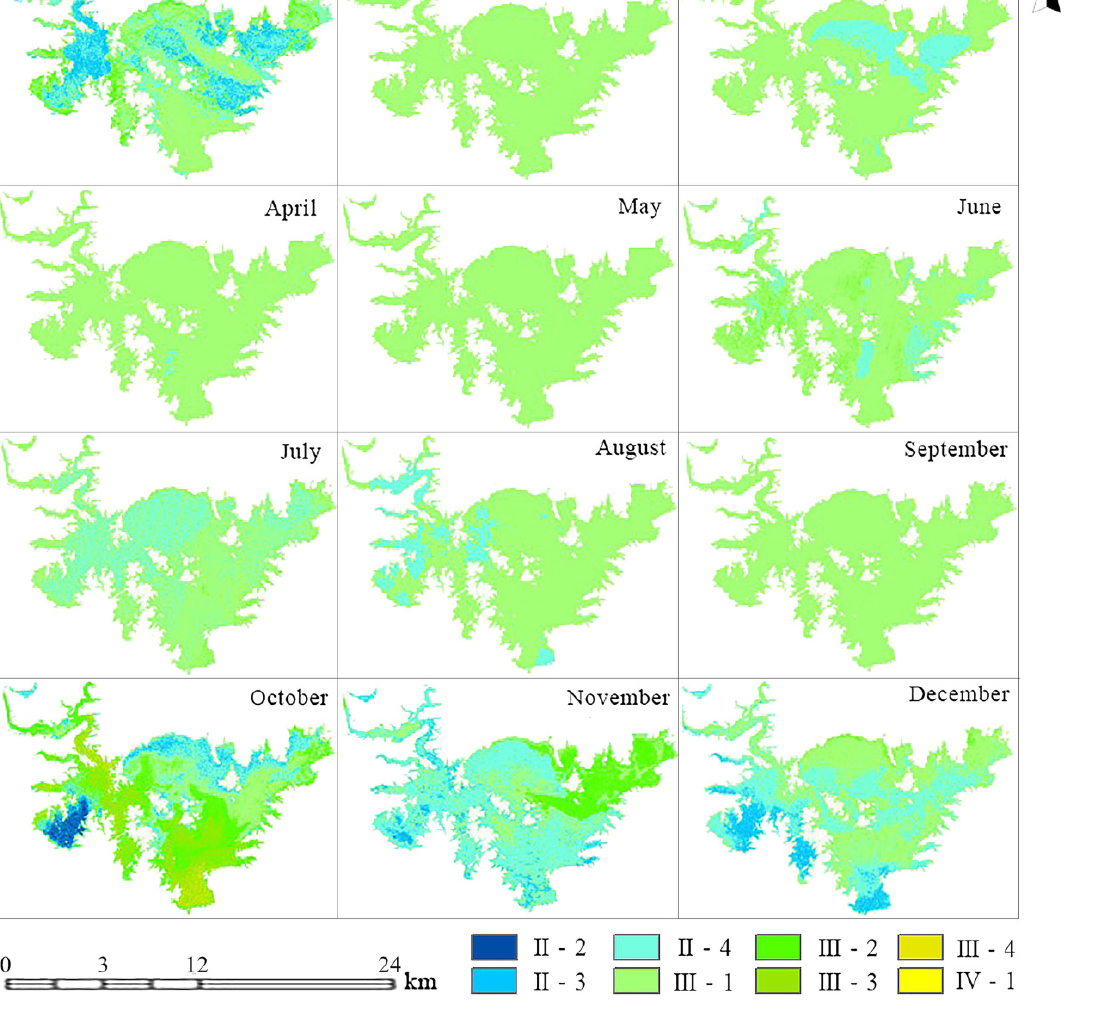
Figure 9. Classification of the TP concentration in Miyun Reservoir. Table 3. The standard limit value of the TP concentration in GB3838-2002.